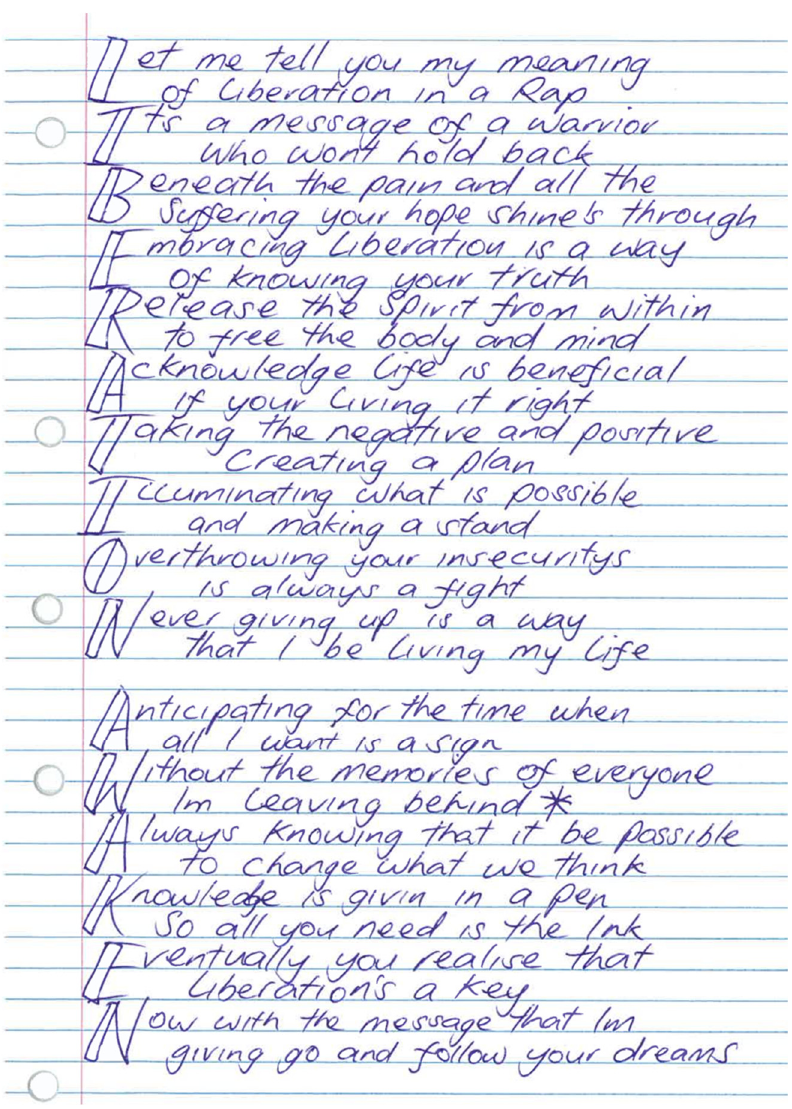
Figure 2. A song written by one of the workshop participants at Auckland Prison responding to the questions about liberation provided by an incarcerated individual at San Quentin.